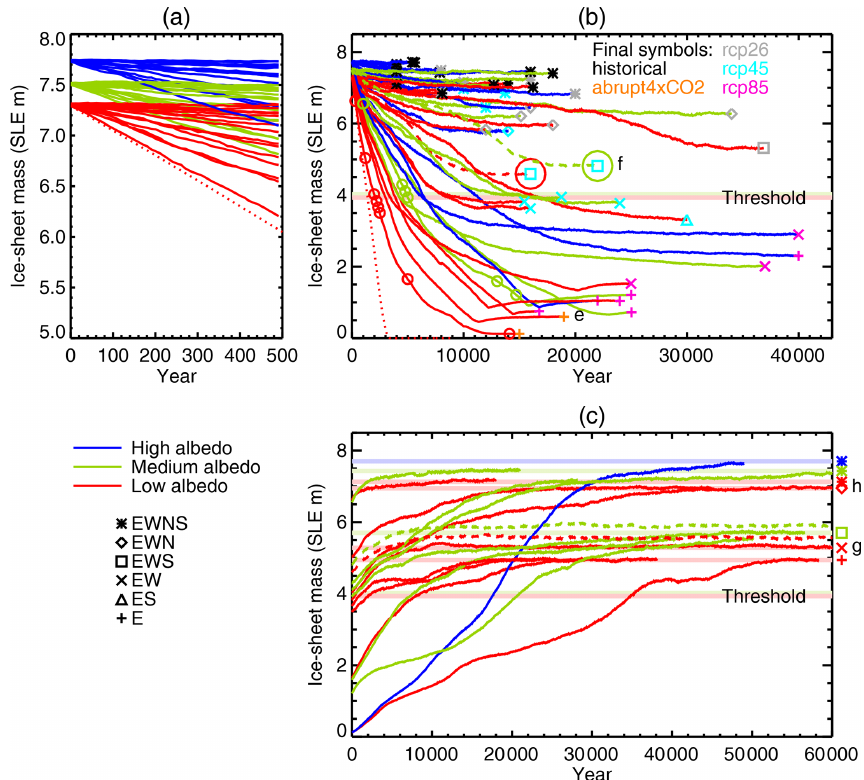
Figure 4. Time series of Greenland ice sheet mass with constant climates. (a, b) First set of experiments, beginning from steady states for MIROC5 historical (1980–1999) climate and continuing until a new steady state is reached under the scenarios indicated by the colours of the final symbols in (b) according to the final symbol colour key in that panel. The solid and dashed lines are FiG experiments; the dotted line is the experiment with the uncoupled Glimmer ice sheet model. The circles indicate transient and final states which provide the initial states for the second set of experiments. (c) Second set of FiG experiments, beginning from states of the same albedo and continuing until a new steady state is reached under the MIROC5 historical climate. The single high-albedo experiment begins from the low-albedo initial state of smallest mass. The experiments shown by dashed lines in (c) begin from the final states of the experiments shown by dashed lines in (b) . In all panels, the FAMOUS–ice albedo is indicated by the line colours. In (b) and (c) , the final symbols denote the configuration of the final steady states, the final states marked “e”–“h” are those shown in the columns indicated in Fig. 3, and the two horizontal lines marked “Threshold” indicate the mass that divides transient states which regrow to nearly the initial steady-state mass (EWNS or EWN configurations) from those which regrow only partially (“no-north” configurations: EWS, EW and